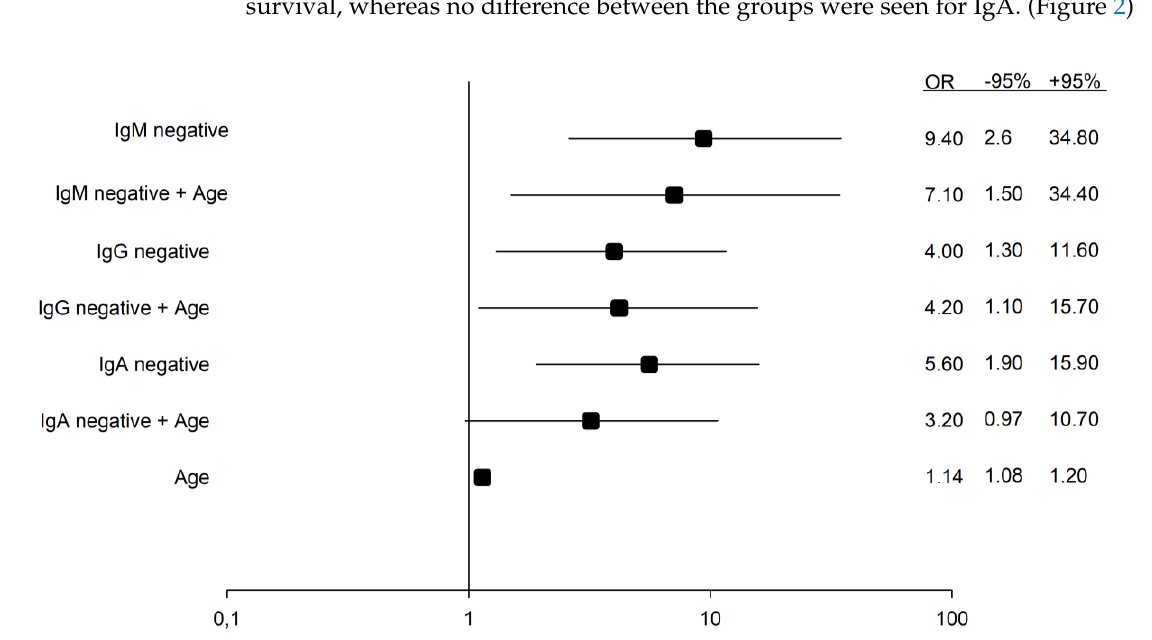
Figure 2. Odds ratios for death in single and multiple logistic regression models with antibody negativity and patient age as independent variables. Increasing age (counted in years) is associated with higher mortality rates.